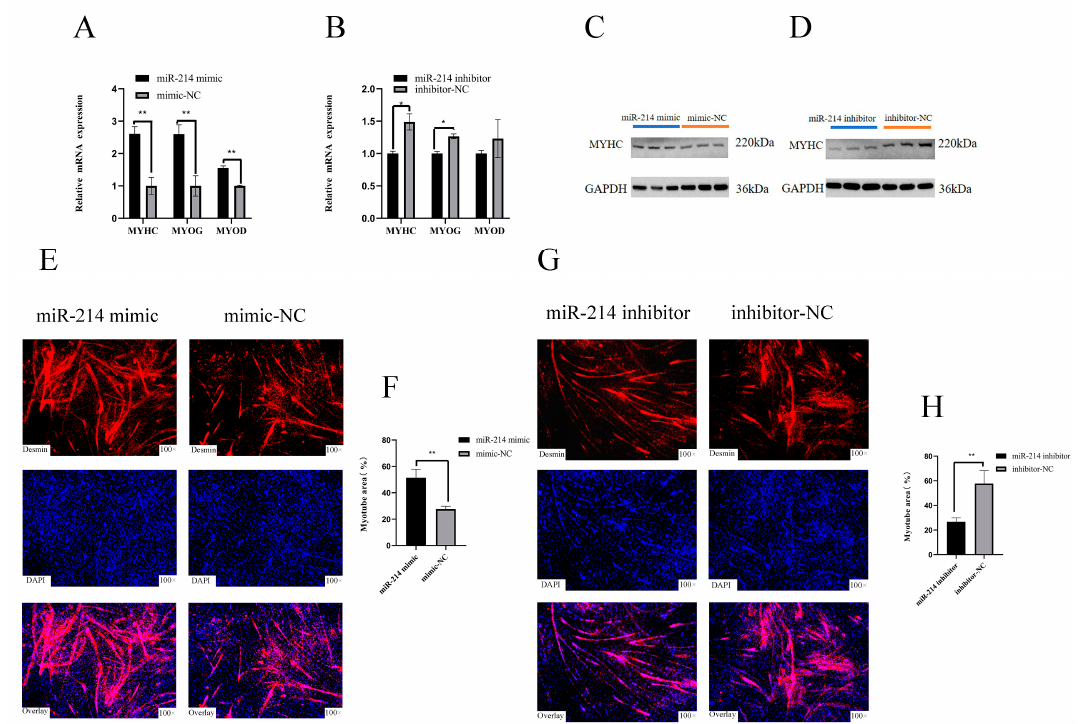
Figure 2. miR-214 promotes the differentiation of chicken myoblasts. ( A , B ) The relative mRNA expression levels of MYHC, MYOG, and MYOD after miR-214 overexpression and interference. ( C , D ) The expression of MYHC protein after miR-214 overexpression and interference. ( E , G ) CPMs stained with Desmin 72 h after miR-214 overexpression and interference. ( F , H ) The proportion of myotube area 72 h after miR-214 overexpression and interference. * p < 0.05 and ** p < 0.01.